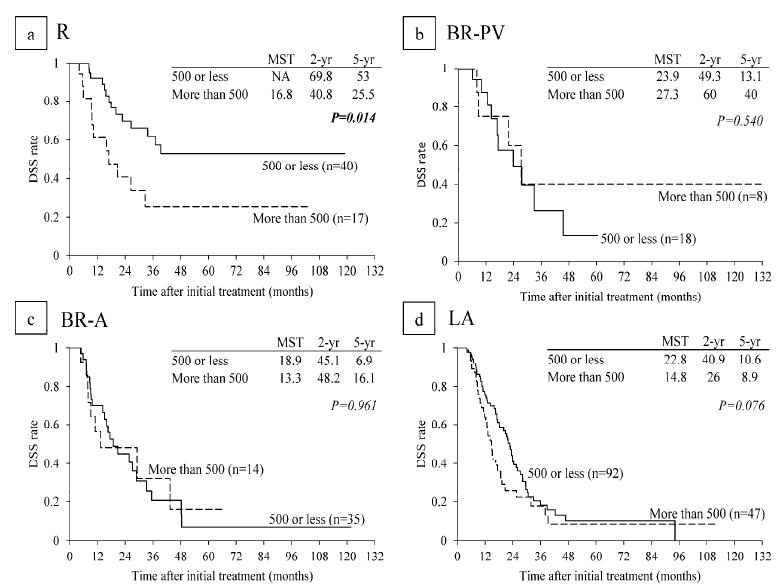
Figure 4. Disease-specific survival (DSS) curves according to ( a ) serum CA 19-9 level * before CRT in the reevaluated patients excluding the 13 patients whose CA 19-9 level was 1 or less U/mL (n = 272); ( b ) according to lymph node metastases on CT before CRT (n = 285); and ( c ) performance status (PS) before CRT (n = 285). * Cut-off value of serum CA 19-9 level before CRT is 500 U/mL. CRT: chemoradiotherapy, NA: not applicable.